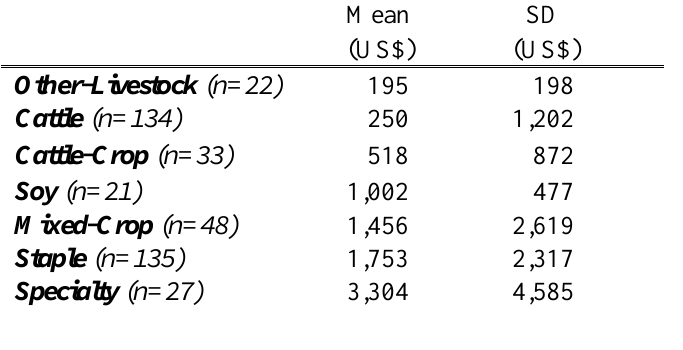
Table A3. 3: Per hectare farm income by land use